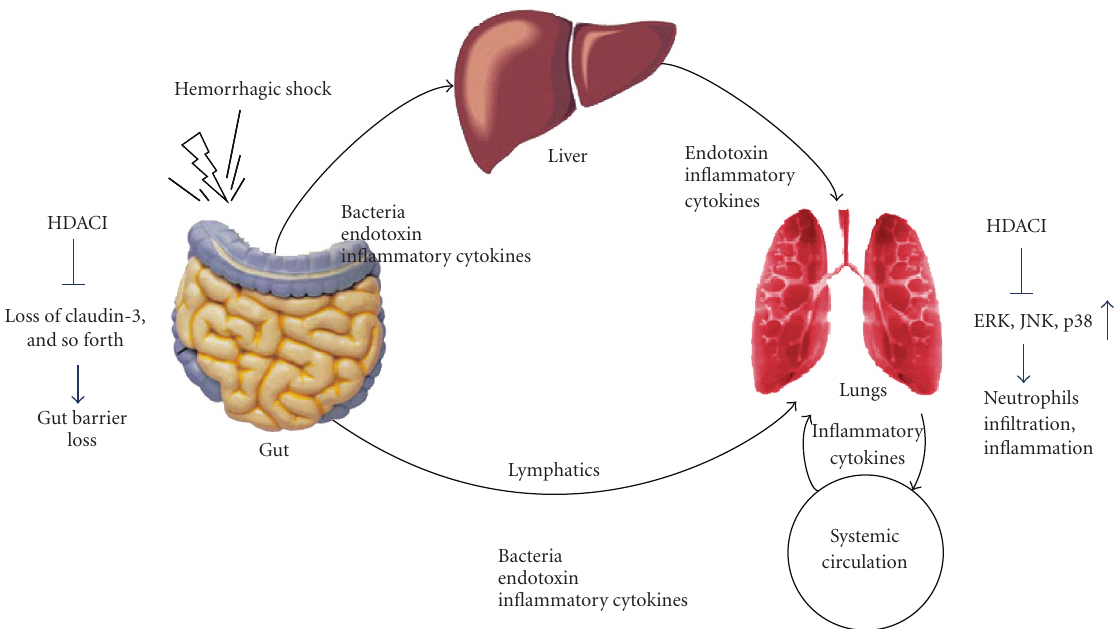
Figure 2: E ff ect of HDACIs on gut-liver/lymph-lung axis in response to hemorrhagic shock. Hemorrhagic shock causes destruction of the gut barrier due to tight junction protein (e.g., claudin-3) loss. Bacteria, endotoxin, and inflammatory cytokines enter into circulation and lung. In the lung tissue, MAPKs are stimulated and neutrophils infiltrated, resulting in acute lung injury. HDACIs block these processing by inhibition of tight junction protein loss in gut and inactivation of MAPKs in